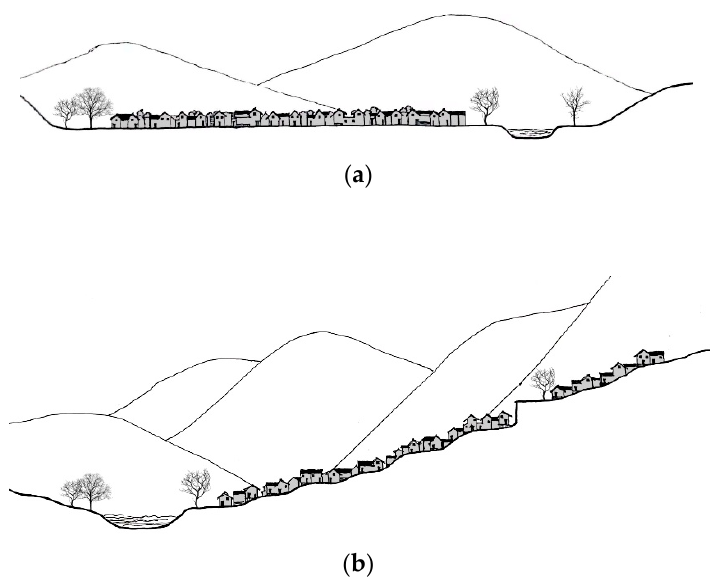
Figure 4. Site elevations of ( a ) Heyang and ( b ) Danzhi.